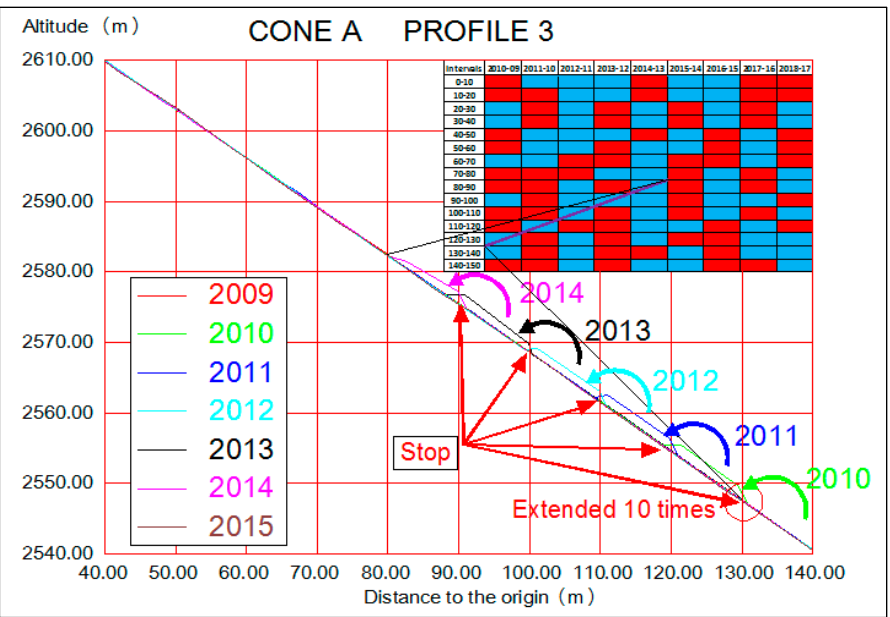
Figure 16. Profile indicating the thickening in retreat over a period of 5 years (2010–14). The thickening effect in the profile is amplified x10.